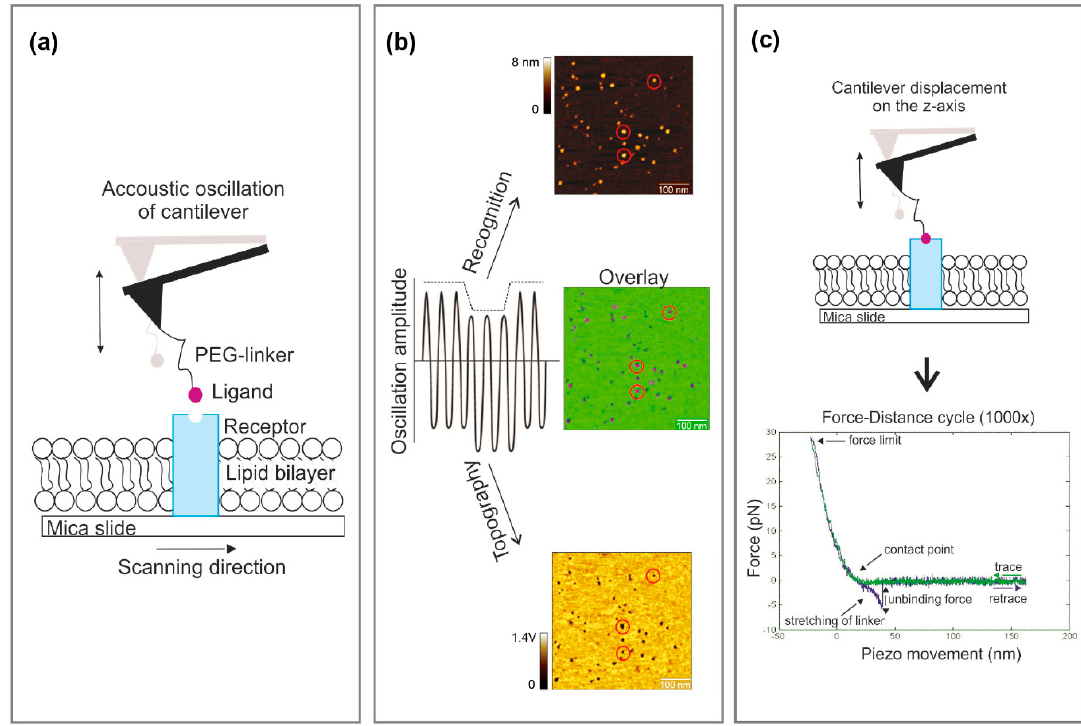
Figure 1. Experimental setup of atomic force microscopy (AFM)-based force spectroscopy guided by recognition imaging. ( a ) Receptors reconstituted into a planar lipid bilayer spread on a mica surface. The cantilever is oscillated by acoustical excitation over the sample surface. ( b ) Simultaneous topographical and recognition (TREC) imaging. The oscillation amplitude is split into two parts. The upper part is taken to construct the recognition image, whereas the lower part is used for the topography image. Specific interaction of the tip-bound ligand with the receptor on the surface leads to a recognition event that is visible as a black dot in the recognition image (red circles). The overlaid image reveals a superposition of the recognition map on the topographical image. ( c ) The cantilever is placed over the functional receptor (i.e., molecules that generated recognition signal (red circles)) and the mode is switched to force spectroscopy. In this mode, the cantilever is repeatedly approached and retracted from the sample surface, resulting in continuous recordings of force–distance cycles. A typical ligand-receptor unbinding event arising from force-induced ligand/receptor dissociation appears as a parabolic-shaped downward signal. Specific unbinding lengths above 10 nm can be attributed to the elasticity of the receptors and the lipid membrane. PEG: Polyethylene glycol.